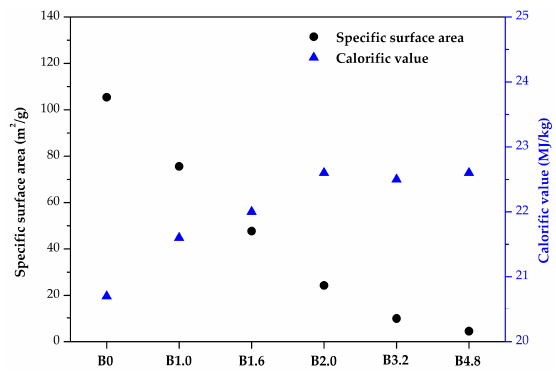
Figure 2. Calorific values and specific surface areas of biochar obtained from the pyrolysis of rice husks with different boric acid contents. (B0, B1.0, B1.6, B2.0, B3.2, and B4.8 were biochar samples prepared by the pyrolysis of rice husks with boric acid contents of 0, 1.0 wt %, 1.6 wt %, 2.0 wt %, 3.2 wt %, and 4.8 wt %, respectively.)